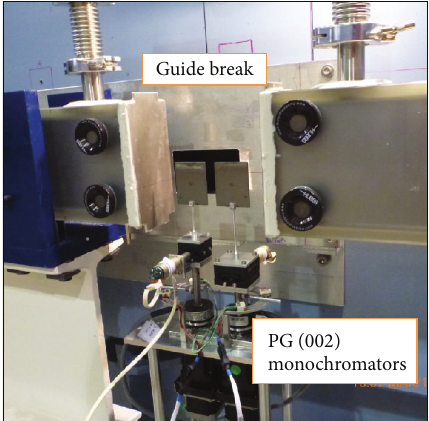
Figure 7: A picture of the monochromators for both beam lines inside the guide shielding of the NG7 guide. The crystals are PG crystals with 0.5 ∘ mosaic placed in the NG7 guide break.